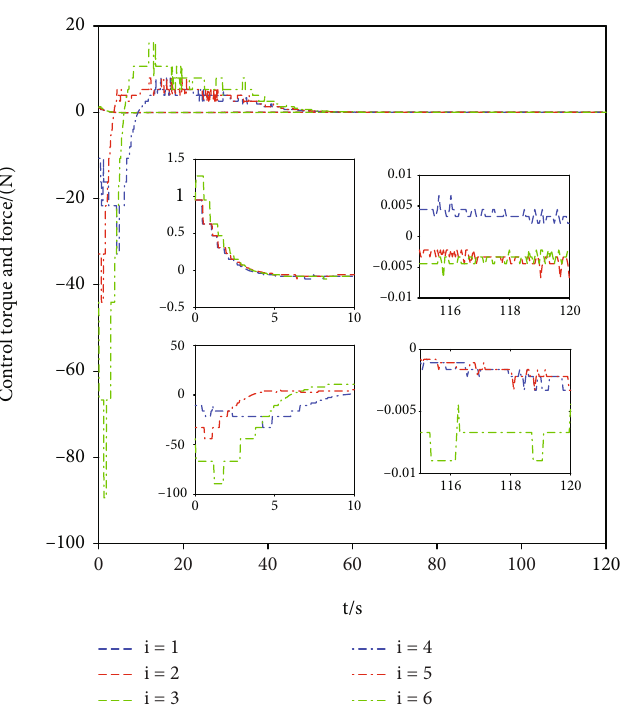
Figure 16: Control torque and force